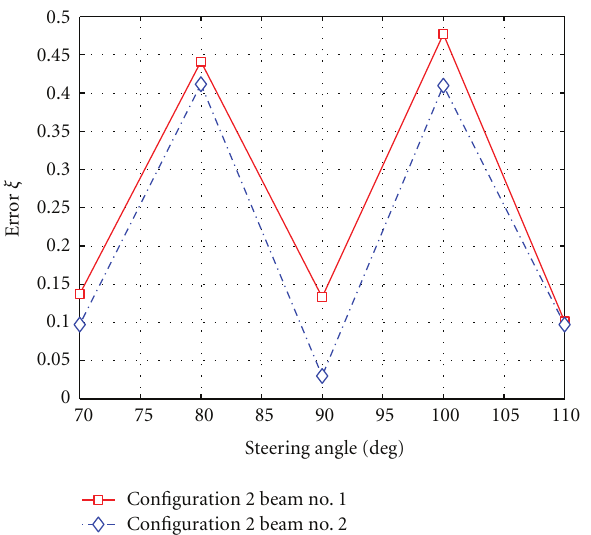
Figure 11: Behavior of the error ξ with respect to the direction of maximum gain for the configuration 2 of